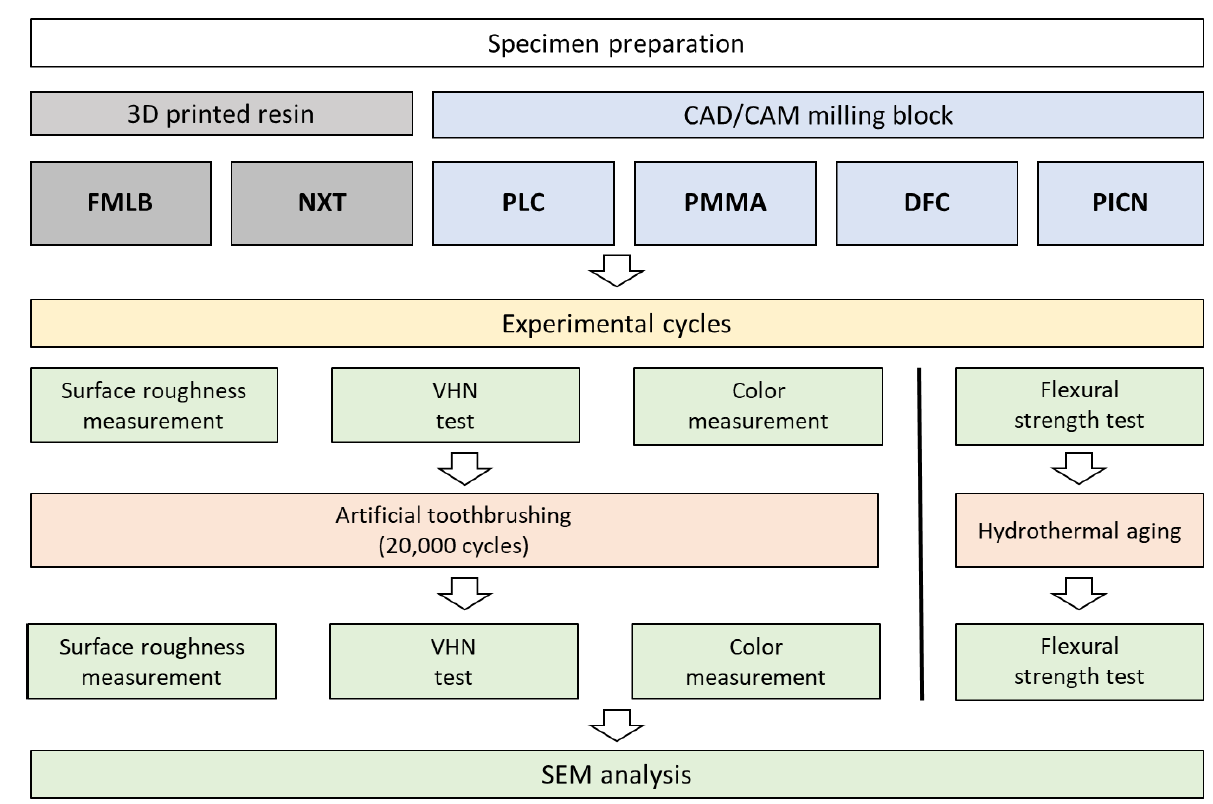
Figure 1. Overall experimental workflow showing the materials used and experimental cycles. Material names are coded as follows: FMLB (Formlabs denture teeth A2 resin), NXT (NextDent C&B), PLC (polycarbonate), PMMA (polymethyl- methacrylate), DFC (dispersed-filler composite), and PICN (polymer infiltrated ceramic network). The following six materials were used in this study and the material names are coded (Table 1): Formlabs denture teeth A2 resin (FMLB) (Formlabs, Sommerville, MA, USA), NextDent C&B (NextDent, Soesterburg, the Netherlands), polycarbonate (PLC) (polycar- bonate block, Line Dental Lab, Seoul, Korea), polymethylmethacrylate (VIPI BLOCK, VIPI, São Paulo, Brazil), dispersed-filler composite (DFC) (MAZIC Duro, Vericom, Chuncheon, Korea), and polymer-infiltrated ceramic network (PICN) (VITA ENAMIC, VITA Zahnfabrik, Bad Säckingen, Germany). Table 1. Characteristics of 3D printing and CAD/CAM blocks used in this study (The composition was written followed by the manufacturer’s information).